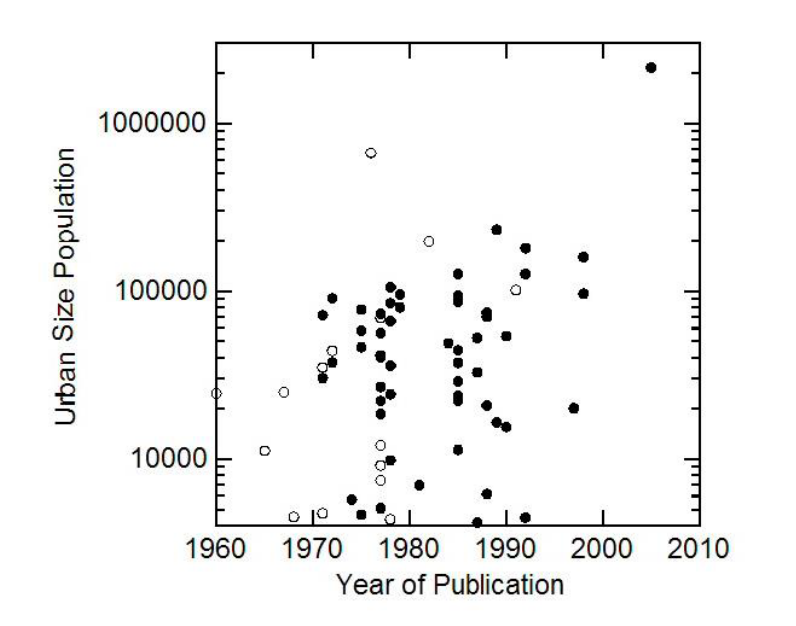
Figure 3. Urban population size and year of the most recent topographic map for 70 Kenyan